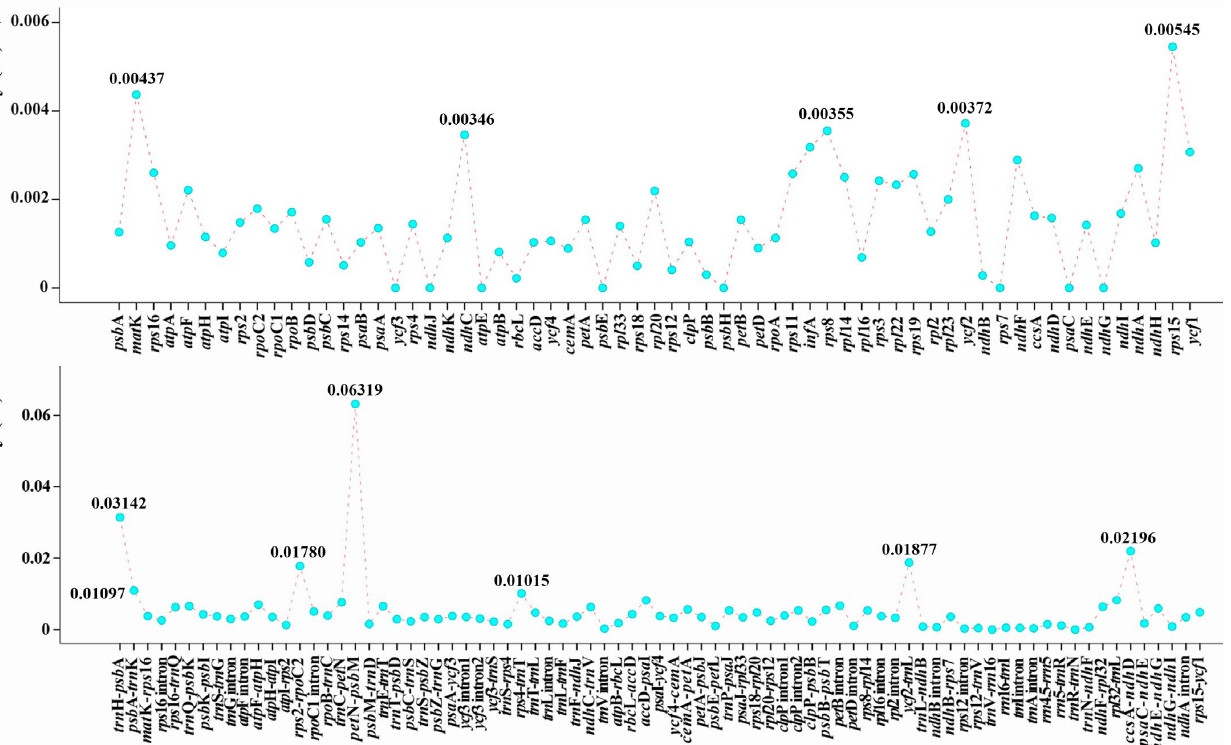
Figure 8. The nucleotide diversity (Pi) values among thirteen plastomes. ( A ) protein-coding regions; ( B ) non-coding and intron regions.